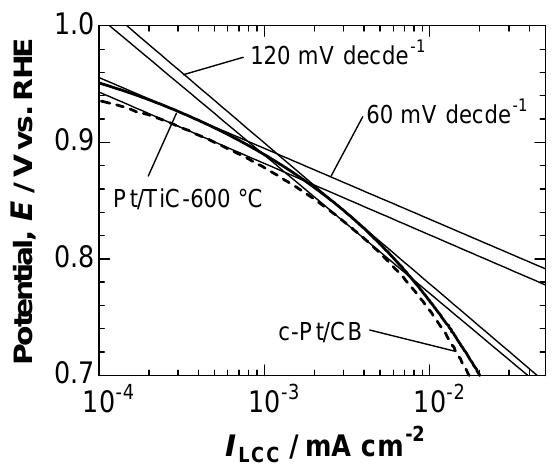
Figure 6. Tafel plots for the ORR at Pt/TiC-600 °C and c-Pt/CB in O 2 -saturated 0.1 M HClO 4 solution at 25 °C with the rotating rate of 1500 rpm and the potential sweep rate of 5 mV s − 1